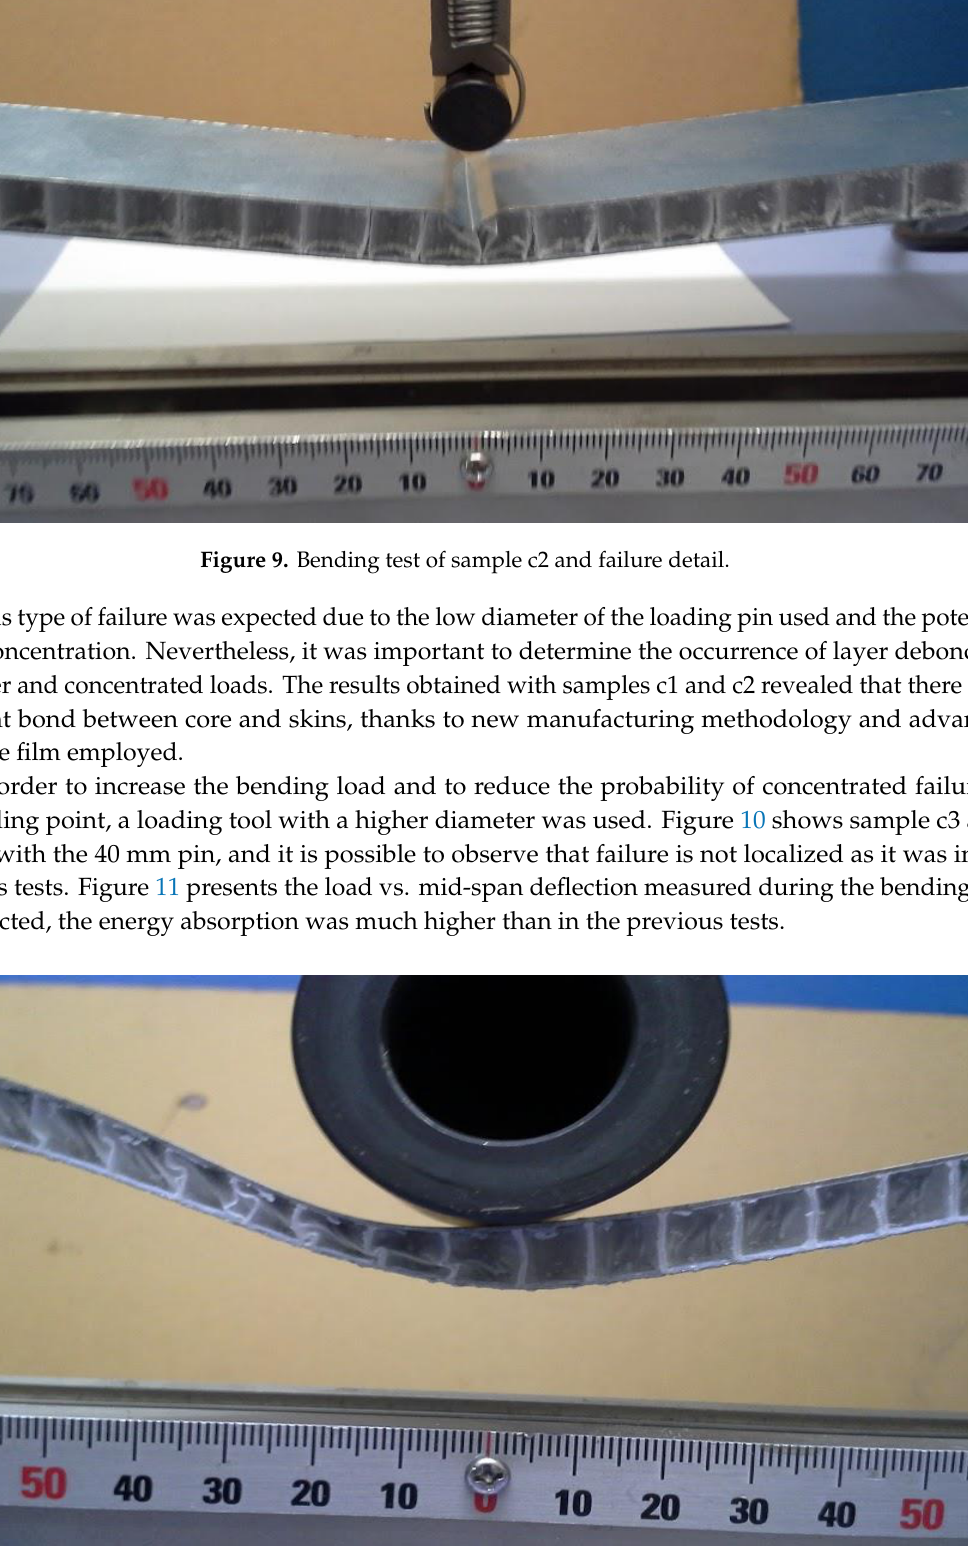
Figure 8. Load vs. mid‐span deflection measured during sample c2 testing.